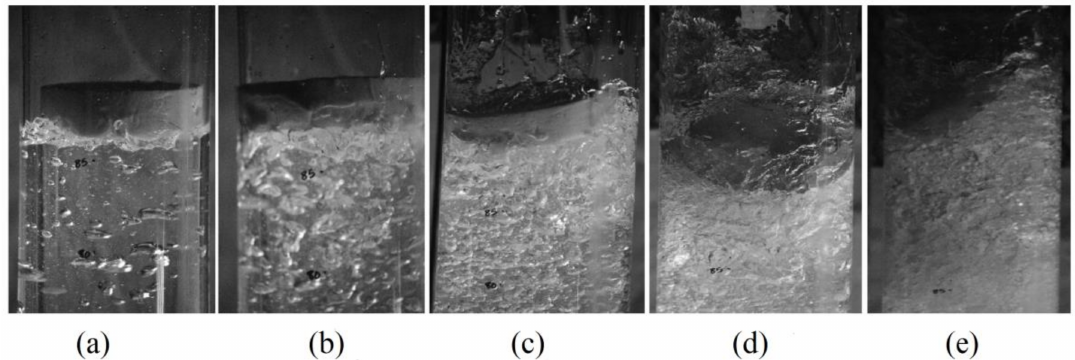
Figure 13. Air-Water interface at f = 12.5 Hz, H 0 = 85 cm and (from left to right) ( a ) A = 1.5 mm ( M ( H ) = 0.035), ( b ) 2.5 mm ( M ( H ) = 0.098), ( c ) 4.5 mm ( M ( H ) = 0.317), ( d ) 6.5 mm ( M ( H ) = 0.661) and ( e ) 9.5 mm ( M ( H ) =